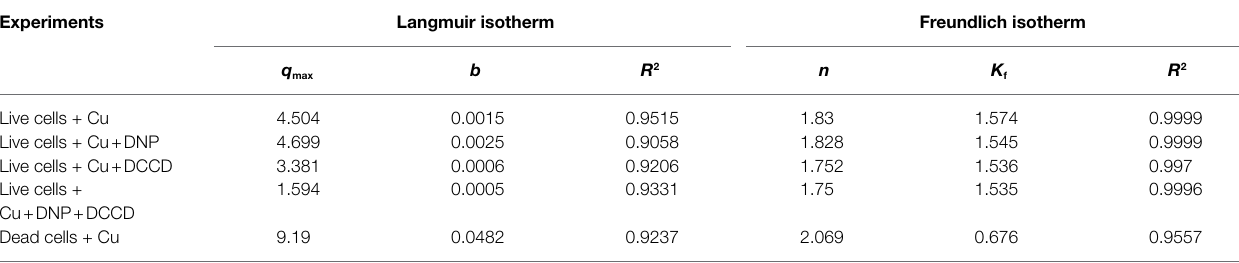
TABLE 2 | Cu adsorption isotherm model constants of B. altitudinis MT422188.